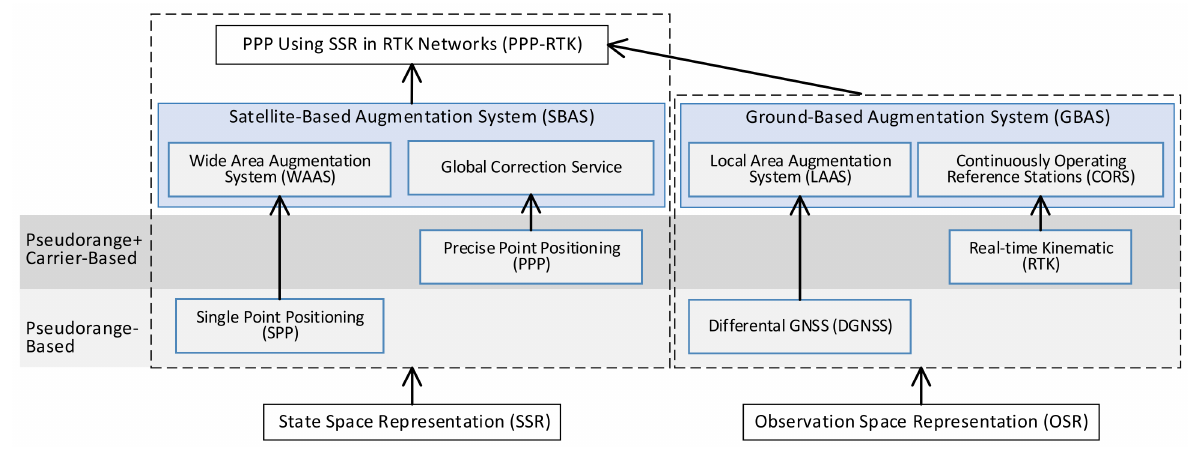
Figure 1. GNSS positioning technology routes and